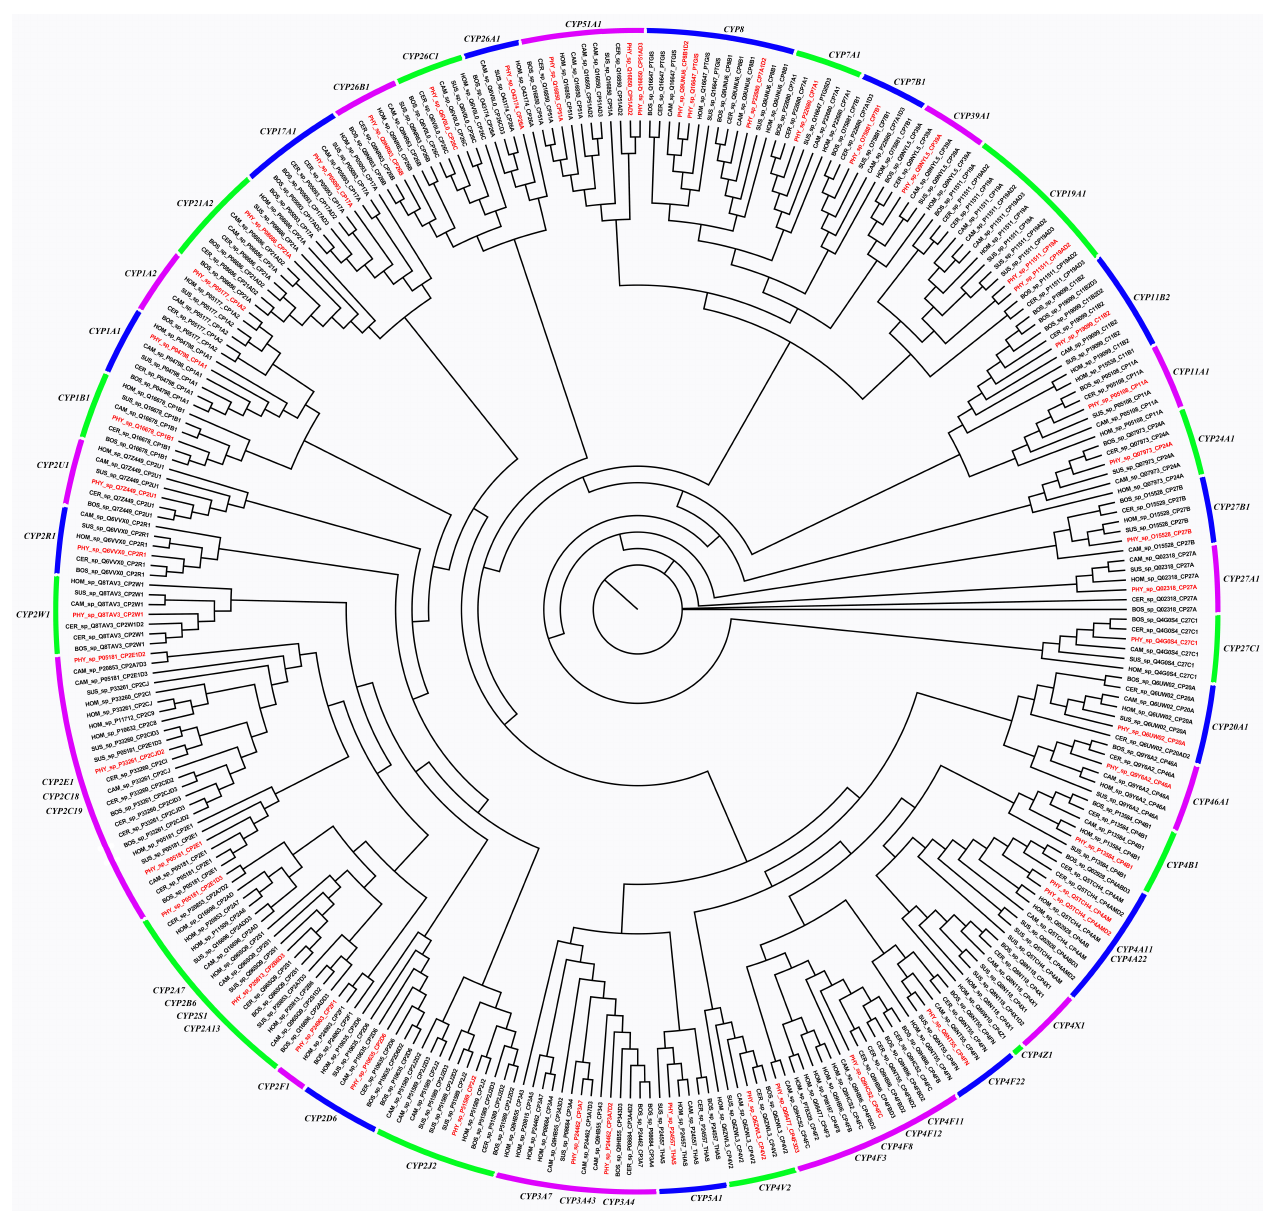
Figure 8. Phylogeny of the cytochrome P450 gene family of sperm whales and five other mammals. In total, 18 CYP families encompassed 52 putative genes from all six mammals, and there were 50 putative genes in 18 CYP families in sperm